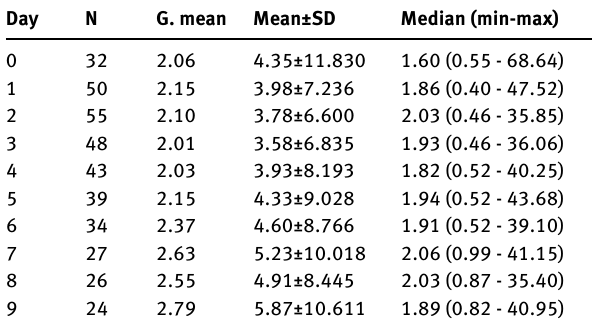
Table 2: Summary of TFF3 levels during a 10 day period